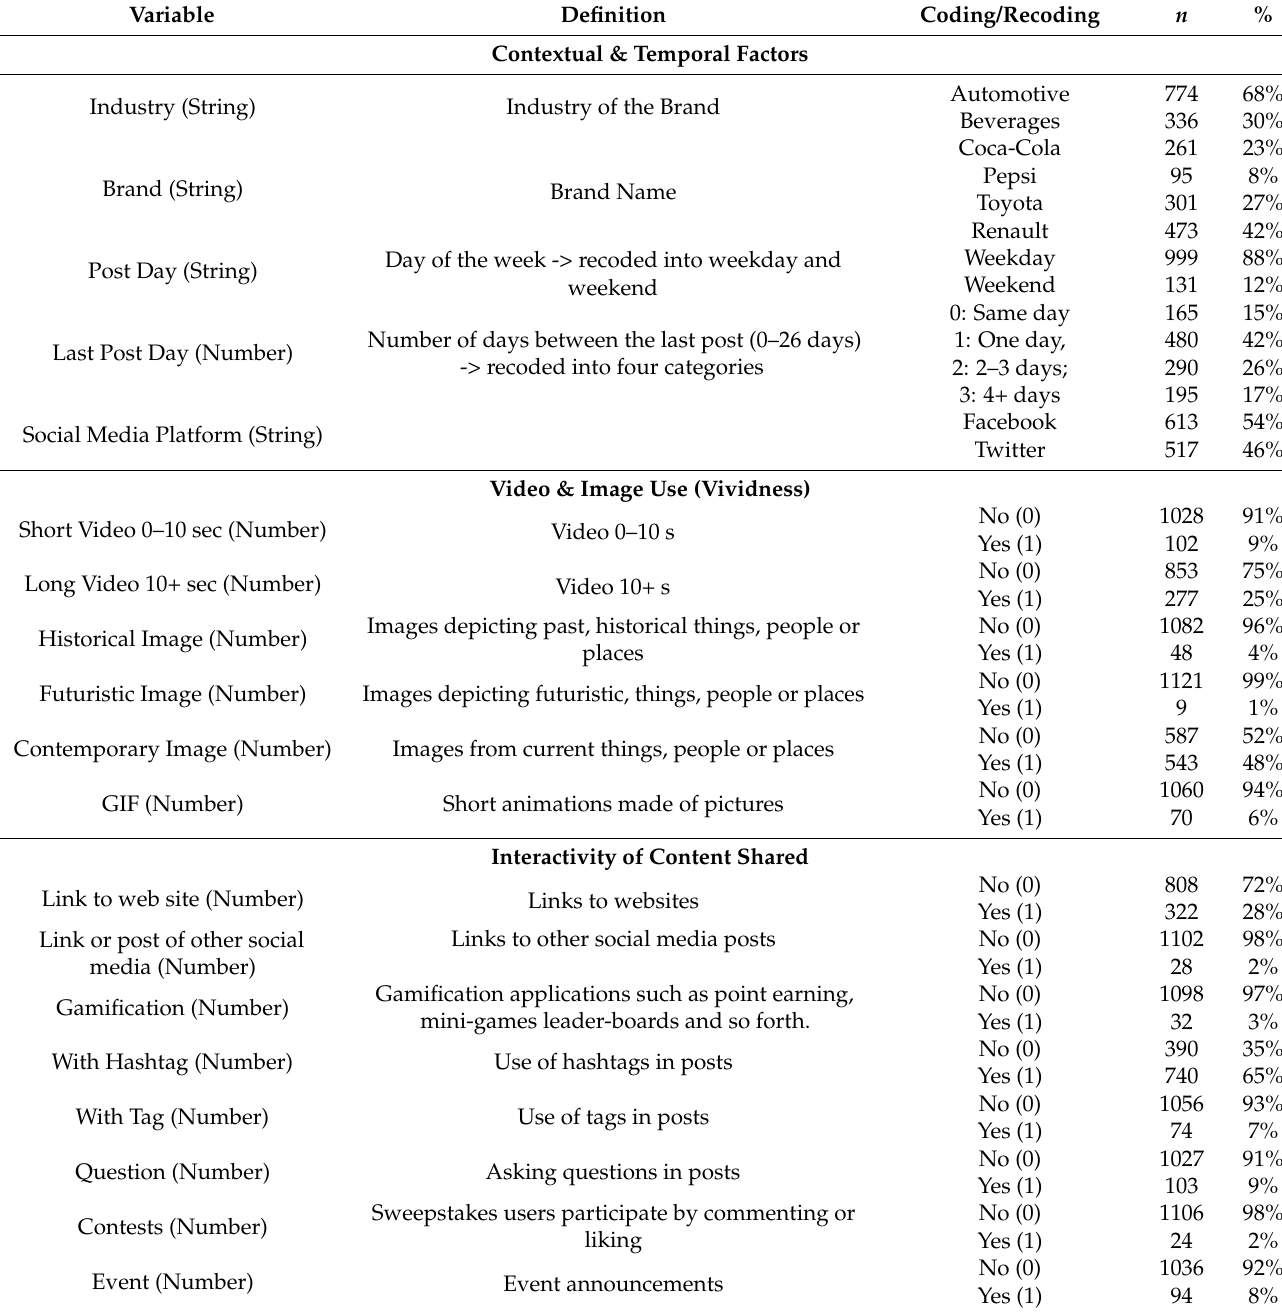
Table 1. Key variables and data